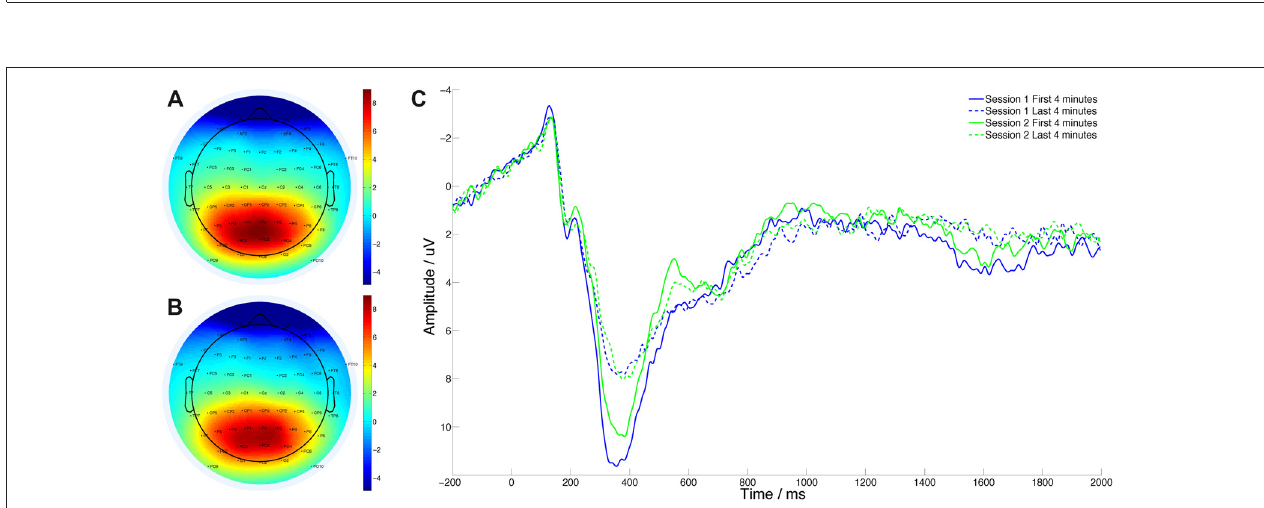
FIGURE 4 | Grand average P3 EEG amplitude topographic plot during PVT. (A) Before intervention. (B) After intervention. (C) Grand average event related potential (ERP) at channel Pz.